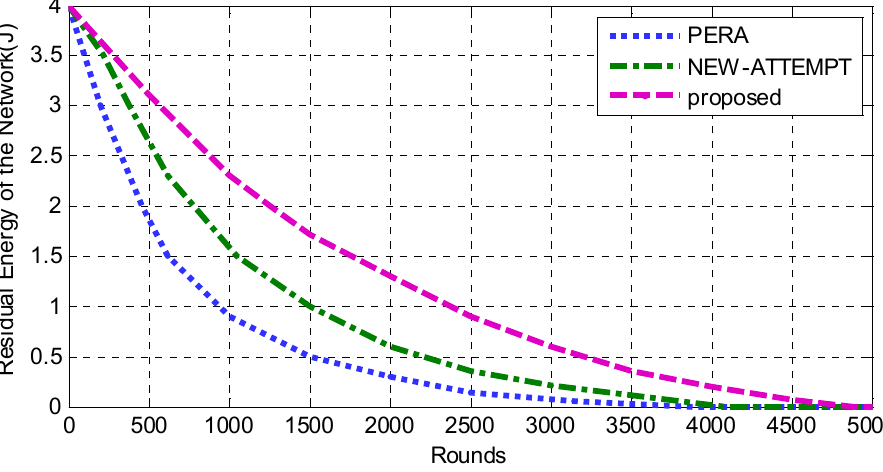
Figure 7. Analysis of energy consumption.